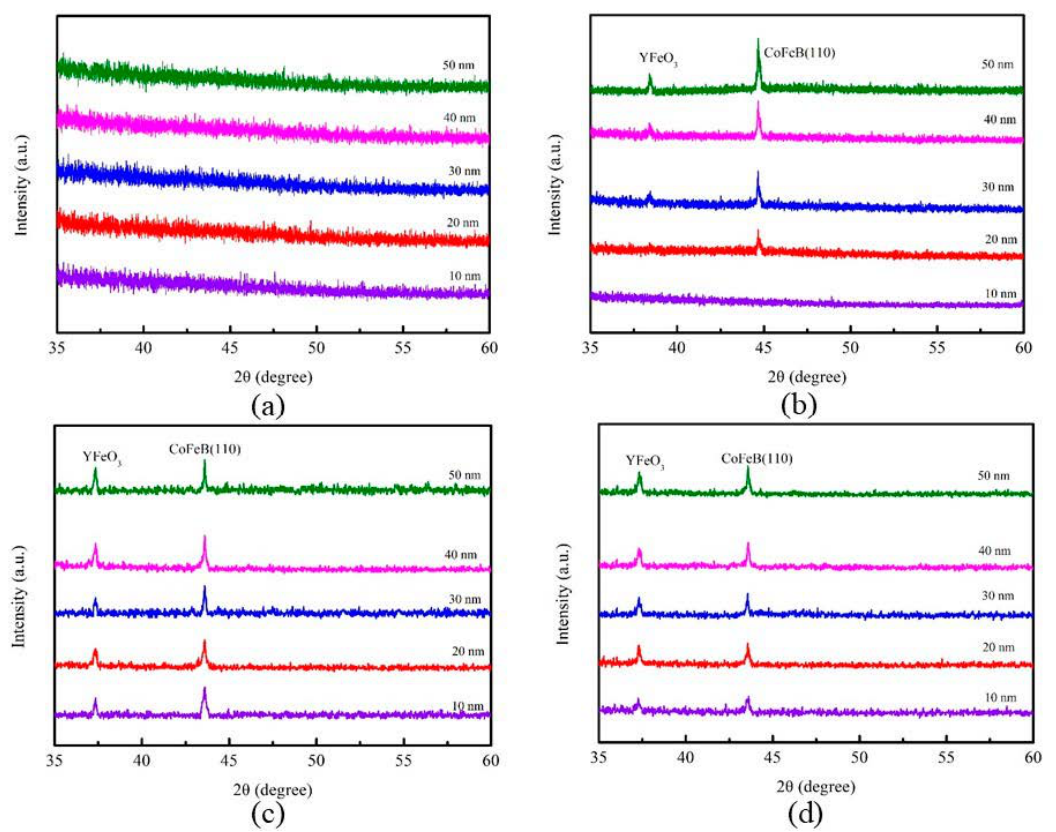
Figure 1. X-ray diffraction (XRD) patterns of CoFeBY films. ( a ) room temperature (RT), ( b ) after annealing at 100 ◦ C, ( c ) after annealing at 200 ◦ C, ( d ) after annealing at 300 ◦